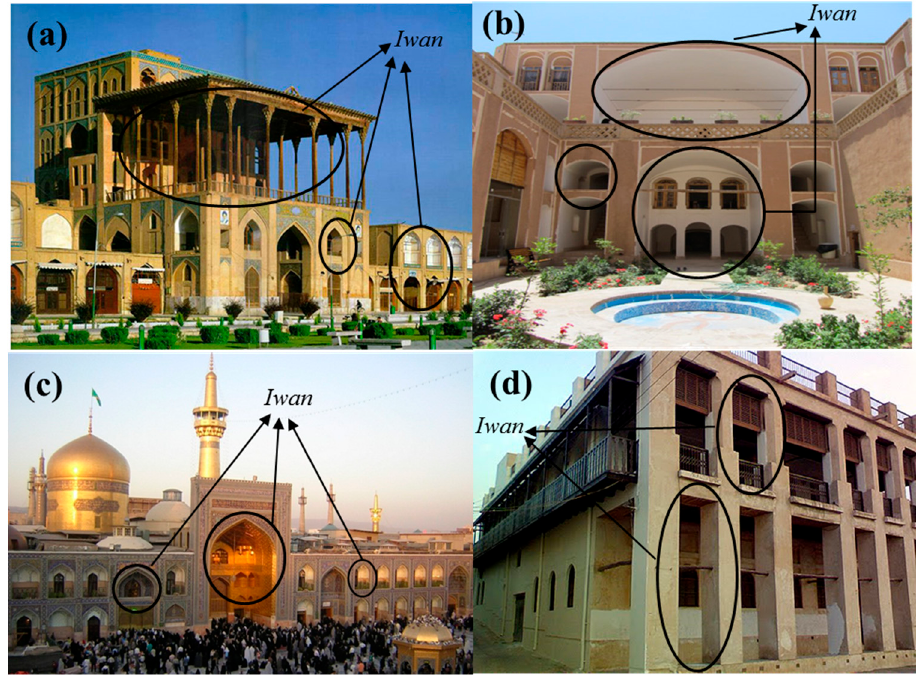
Figure 1. Different forms of Iwan. ( a ) Ali Qapu palace (Isfahan); ( b ) Ooomiha House (Yazd); ( c ) Imam Reza Shrine (Mashhad); ( d ) Amiriye Mansion (Bushehr).